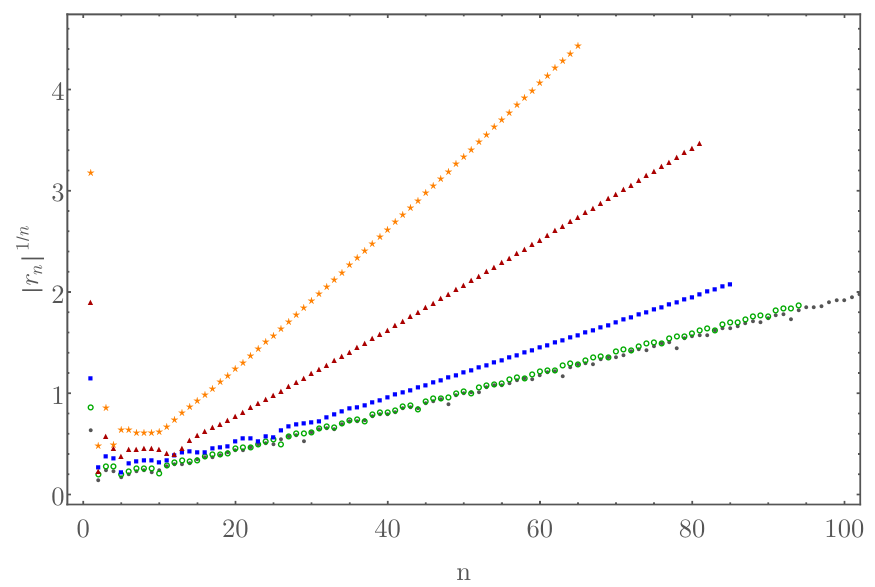
Figure 1 . Behaviour of the series coe(cid:14)cients for the anisotropy function eq. (2.5) as a function of the expansion order n for (cid:21) GB = 0 (grey solid circles), (cid:21) GB = (cid:0) 0 : 1 (green open circles), (cid:21) GB = (cid:0) 0 : 2 (blue squares), (cid:21) GB = (cid:0) 0 : 5 (red triangles) and (cid:21) GB = (cid:0) 1 (orange